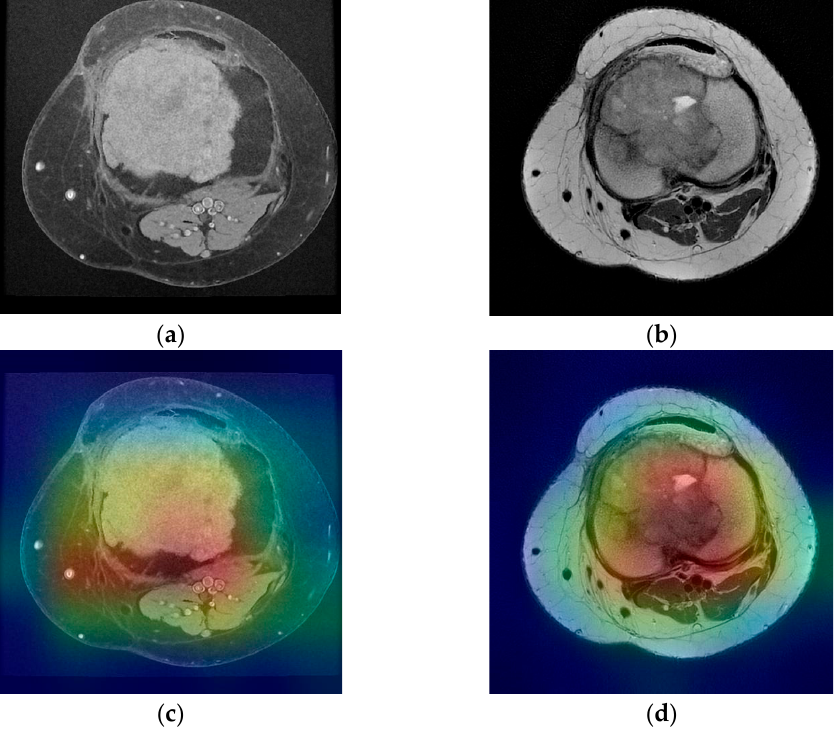
Figure 7. ( a ) Tibia benign tumor -T1 FS weighted image; ( b ) tibia benign tumor—T2 weighted image; ( c , d ) corresponding class activation maps.